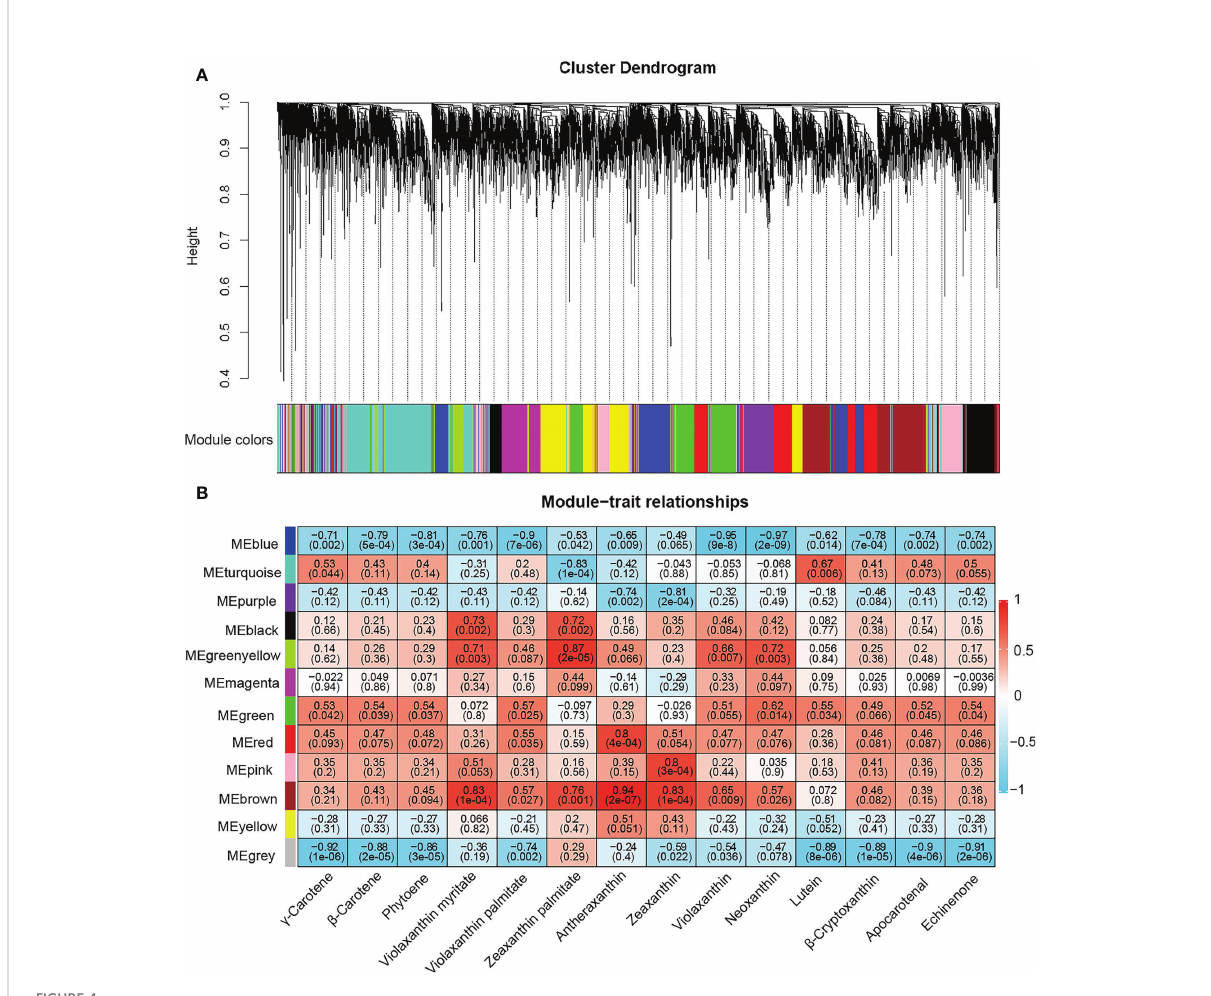
FIGURE 4 Weighted gene co-expression network analysis (WGCNA) of differentially expressed genes. (A) Hierarchical clustering tree showing 12 gene modules of co-expressed genes, each module labeled with different color. Each leaf in branch of the tree represented one gene. (B) Relationship between gene module and carotenoids contents in sweetpotato cultivars. Each row corresponds to a module, labeled with different colors. Each column represents a carotenoid component. The values in each cell represent the correlation coef fi cient and P value between the module and carotenoids and displayed according to the color scale on the